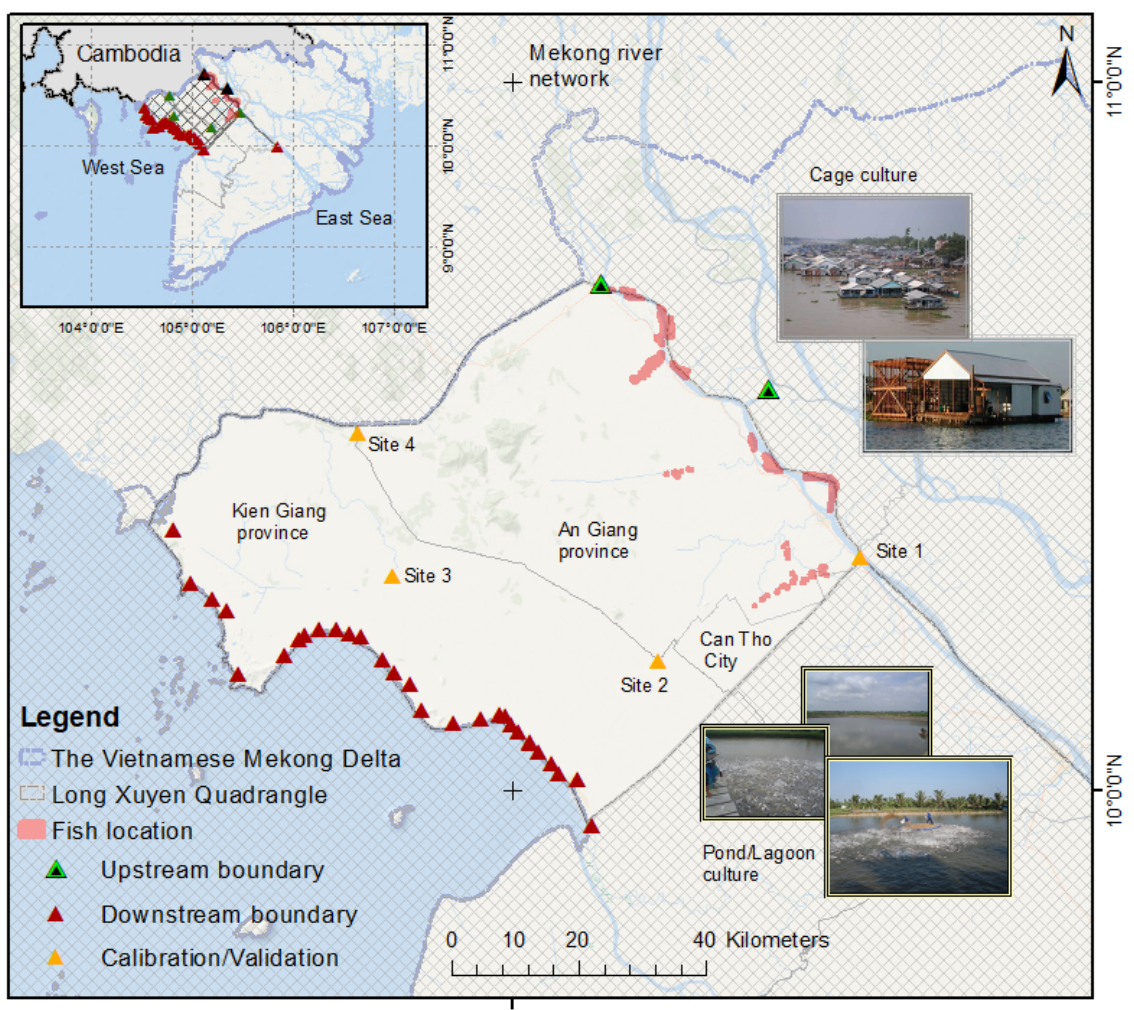
Figure 1. Map of the Vietnamese Mekong Delta and the Long Xuyen Quadrangle (LXQ) with its upstream and downstream boundaries. Calibration and validation samples were collected in the provinces of An Giang, Kien Giang and Can Tho. Long Xuyen Canal = 1, Vinh Tre Canal = 2, Rac Gia-Long Xuyen Canal = 3 and Tam Ngan Canal = 4.